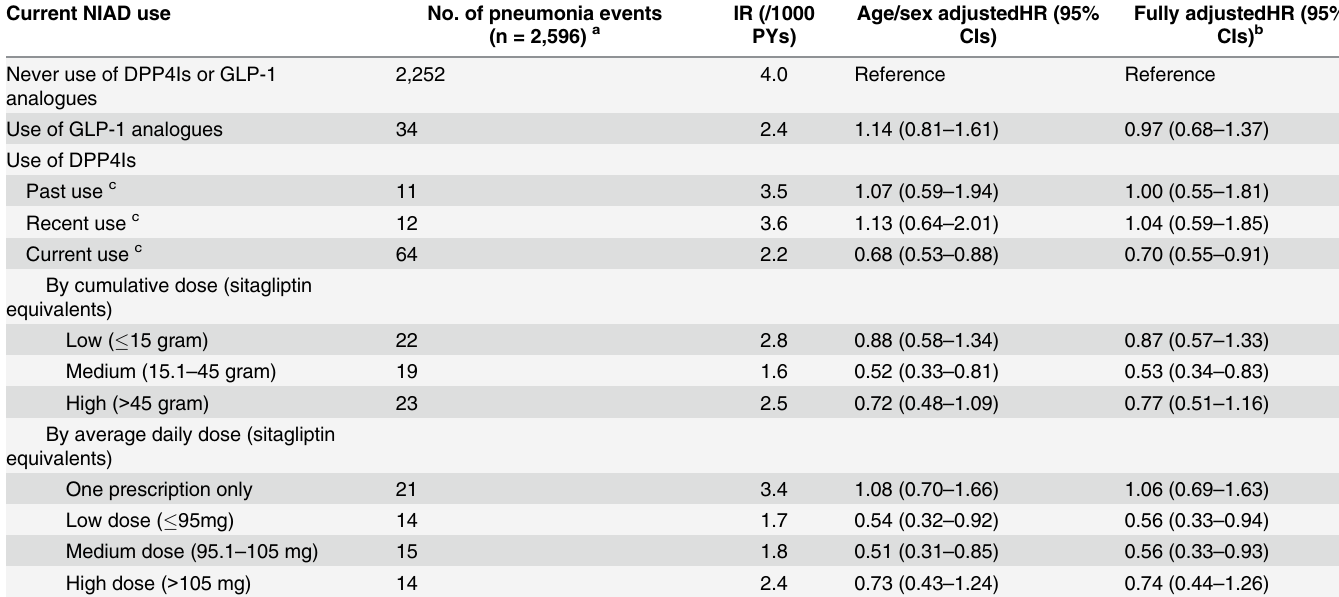
Table 2. Use of DPP-4 inhibitors and risk of pneumonia in T2DM patients, by cumulative dose and daily